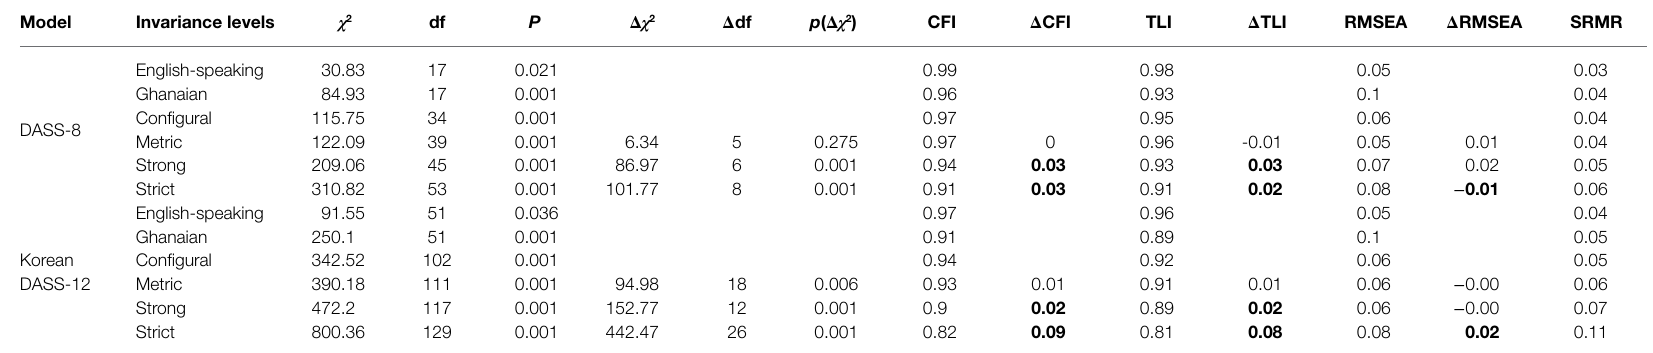
TABLE 3 | Invariance of factor structures of the Depression Anxiety Stress Scale 8 (DASS-8) and DASS-12 across English-speaking and Ghanaian student groups. Model Invariance levels